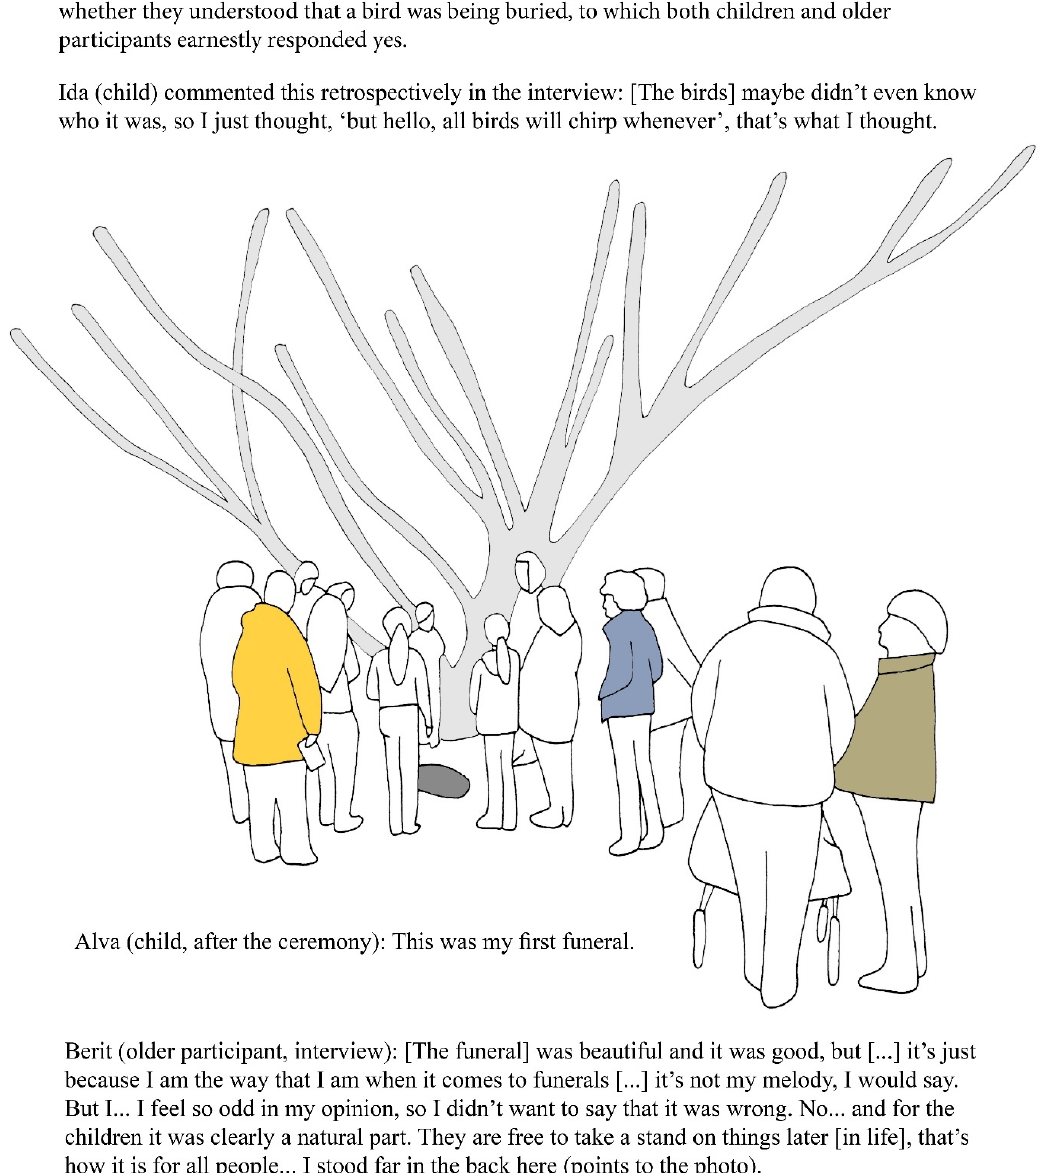
Figure 3. Funeral for a bird (illustration by author MK, based on a photograph of the workshop). During the last Studio DöBra 1 workshop, participants created an exhibition at the children’s library, displaying their products accompanied by their texts and collages of workshop photographs, after which they role-played its’ opening event. The day after, outsiders were invited to the formal opening of the exhibition. The funeral for the bird was also conceptualized as a goodbye to Studio DöBra 2. Alva (child) not only wrote a farewell note to the dead bird, but also to Studio DöBra, which she left in the project room: “It was a lot of fun to participate [in Studio DöBra] ! It was a pity that the bird died because it could have lived longer and done more in life!” After the ceremony, a group of guests were invited to an event during which partici- pants showed what they had created. While older adults said they had no-one to invite, children invited family and friends, and partners invited colleagues and journalists.